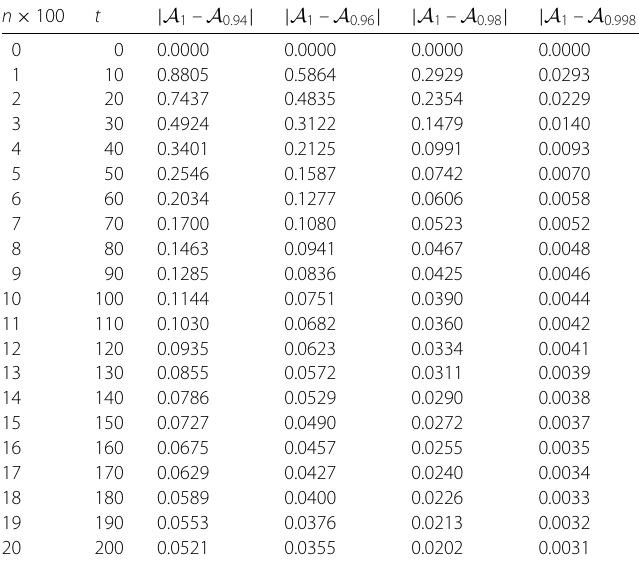
Table 9 The values of | A 1 – A φ | for φ = { 0.94,0.96,0.98,0.998 }